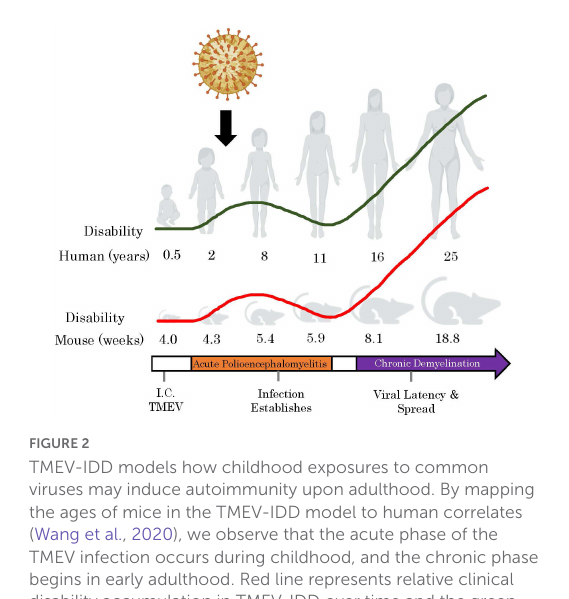
FIGURE2 TMEV-IDD models how childhood exposures to common viruses may induce autoimmunity upon adulthood. By mapping the ages of mice in the TMEV-IDD model to human correlates (Wang et al., 2020), we observe that the acute phase of the TMEV infection occurs during childhood, and the chronic phase begins in early adulthood. Red line represents relative clinical disability accumulation in TMEV-IDD over time and the green line shows this with respect to human years. I.C, intracranial. This figure was illustrated using